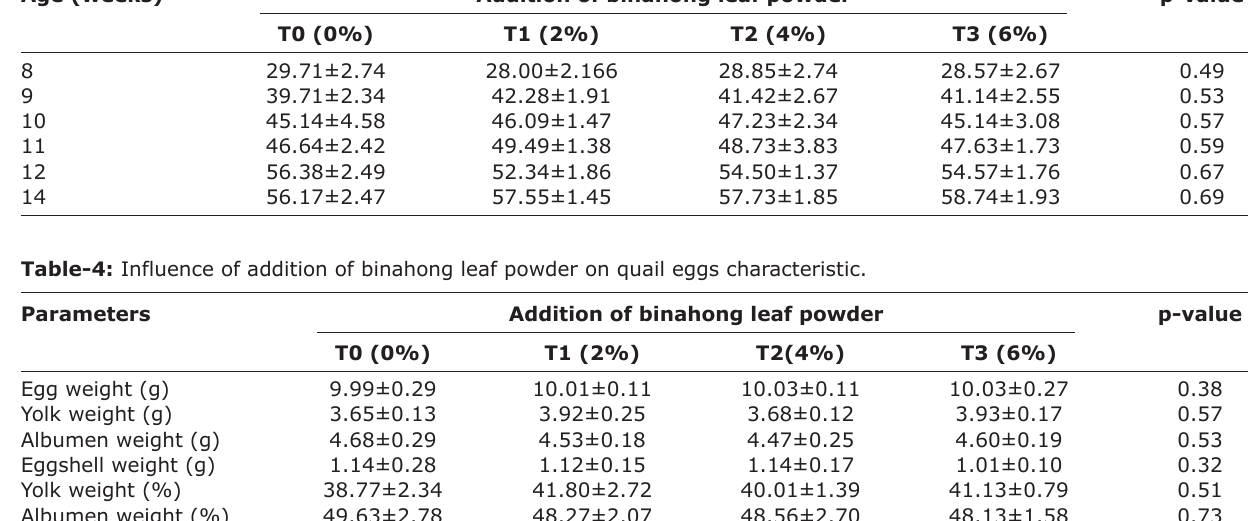
Table-3: Egg production on addition of binahong leaf powder in quail rations. Age (weeks)